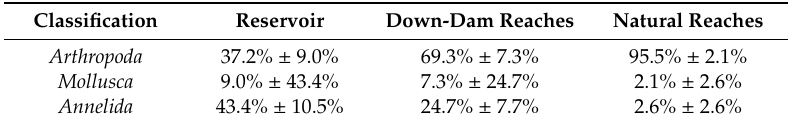
Table 5. Proportion (Mean ± SD) of di ff erent individual macroinvertebrate taxa in the reservoirs, down-dam reaches, and natural reaches, stratified by phylum in